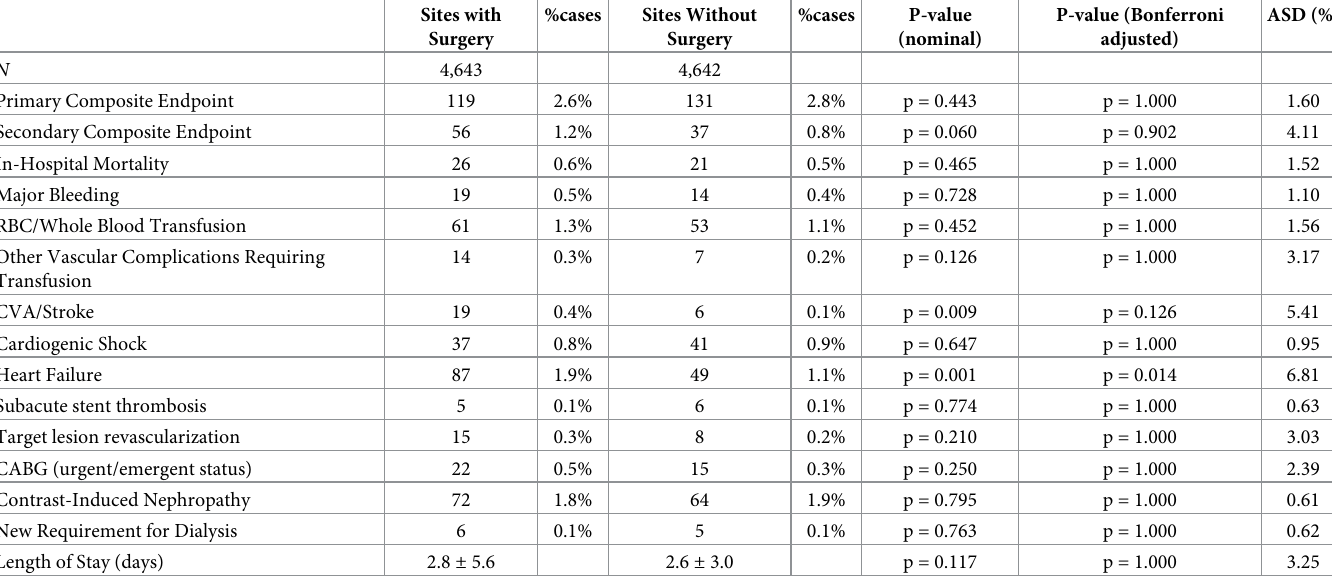
Table 2. Outcomes and complications of matched elective PCI cohorts at sites with and without surgery